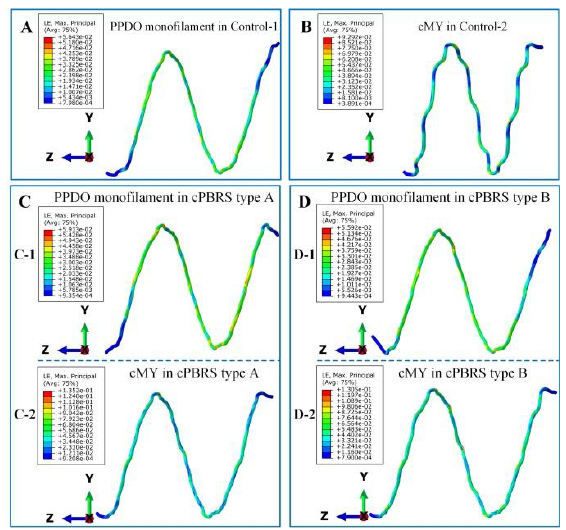
Figure 10. The logarithmic strain distributions of typical yarn in different prototypes after balloon-expanding simulation. ( A ) PPDO monofilament of the Control-1 prototype. ( B ) cMY of the Control-2 prototype. ( C ) Different components of the cPBRS type A prototype: ( C-1 ) PPDO monofilament; ( C-2 ) cMY. ( D ) Different components of the cPBRS type B prototype: ( D-1 ) PPDO monofilament; ( D-2 ) cMY.